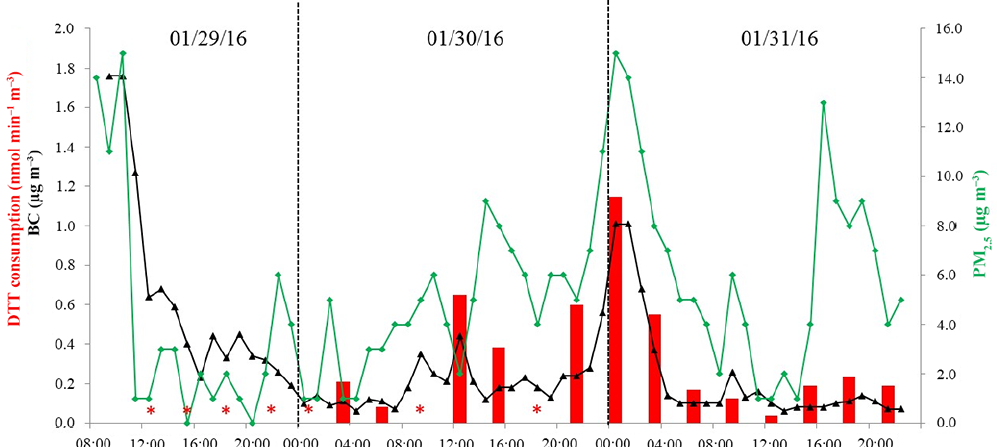
Figure 6. DTT consumption rate (nmolmin − 1 m − 3 ) for 3h samples collected and analyzed using o-MOCA for 3 consecutive days at Berkeley, CA; PM 2 . 5 and black carbon (µgm − 3 ) data obtained from nearby monitoring station (AQMD); ∗